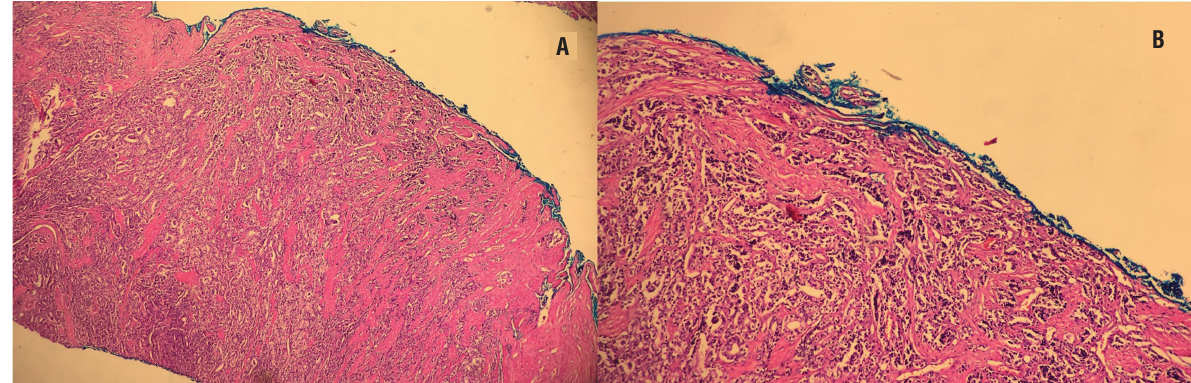
Figure 1A and 1B - Acinar adenocarcinoma with Gleason 4 pattern. It is shown with 40 X and 100 X magnification respectively. Positive surgical margin length 3 mm.